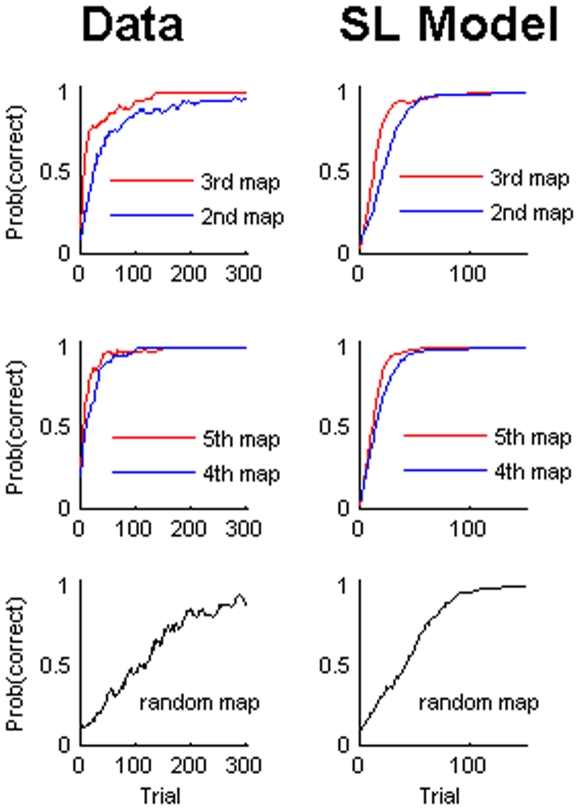
Trial-by-trial evolution of learning.For the experimental data we averaged over subjects to compute the probability that the correct action was chosen on the basis of the fraction of subjects that chose the correct action in each trial. For the model we determined the probability of choosing the correct action by computing the probability of choosing the correct action given the action and observation stream of each subject and again averaged over subjects. All curves were smoothed with a Savitzky-Golay-Filter of polynomial order 1 and length 11.